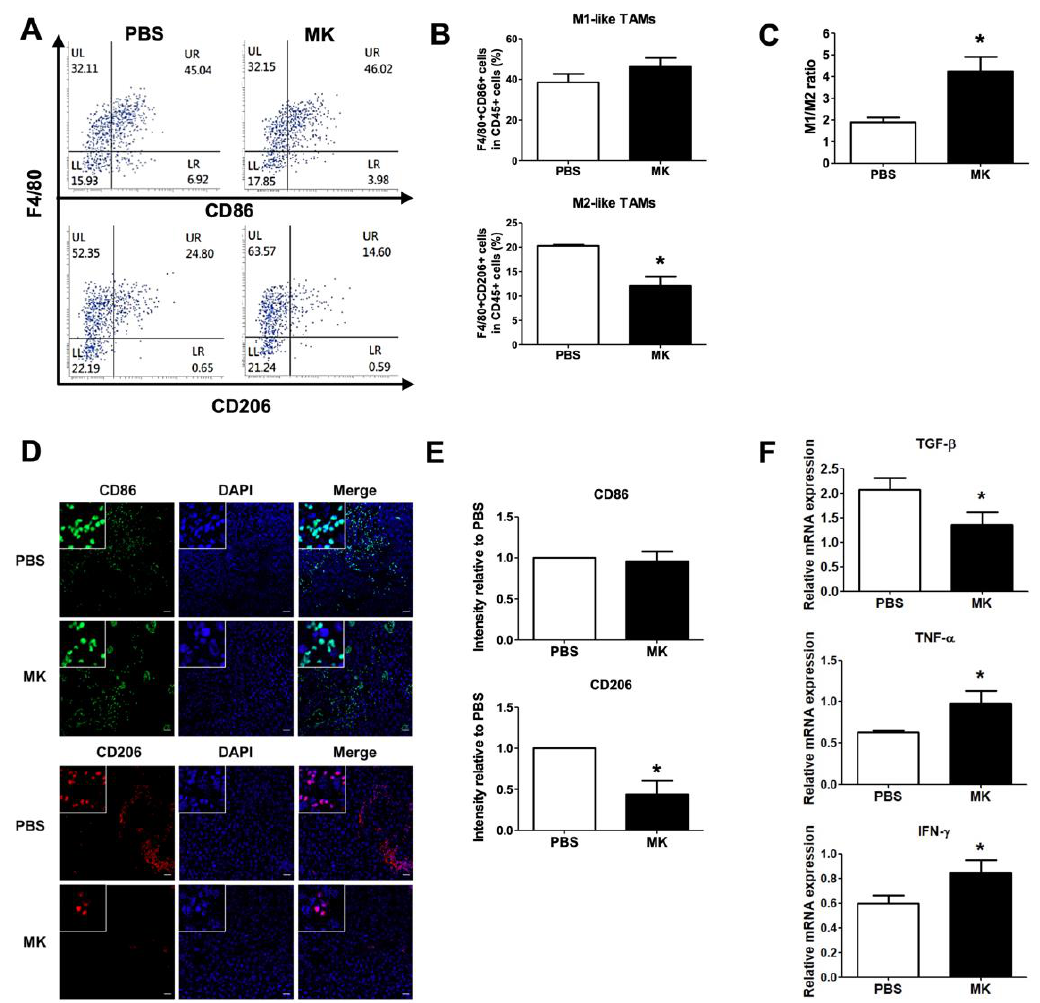
Figure 7. Reduction of M2-like TAMs by melittin–dKLA in a mouse model of melanoma. Single cells were harvested from tumor tissues. ( A ) M1-like TAMs were stained as CD45 + F4/80 + CD86 + (upper panel), and M2-like TAMs were marked as CD45 + F4/80 + CD206 + (bottom panel). The cells are shown as dot plots within the F4/80 and CD86 or CD206 axis gated on CD45 + cells. ( B ) Data for each cell phenotype are displayed as the percentages of F4/80 + CD86 + M1- (upper) and F4/80 + CD206 + M2-like TAMs (bottom) in CD45 + cells. ( C ) The M1/M2 ratio was calculated on the basis of the percentage of F4/80 + CD86 + M1-like and F4/80 + CD206 + M2-like TAMs in CD45 + cells. ( D ) Expression of CD86 and CD206 in tumor tissues was determined by immunofluorescence staining assay. Confocal images of a tumor tissue slice stained for CD86 (green), CD206 (red), and nucleus (DAPI; blue). ( E ) The graph is presented as intensity relative to PBS. ( F ) Expression of TGF- β , TNF- α , and IFN- γ mRNA in tumor tissues was analyzed by quantitative real-time PCR. All data are presented as means ± SD ( n = 5); * p < 0.05 versus the PBS group.